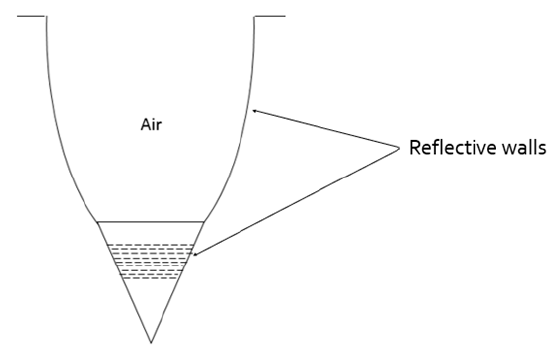
Figure 21 . LENS pixel reflective walls. Figure 21. LENS pixel reflective